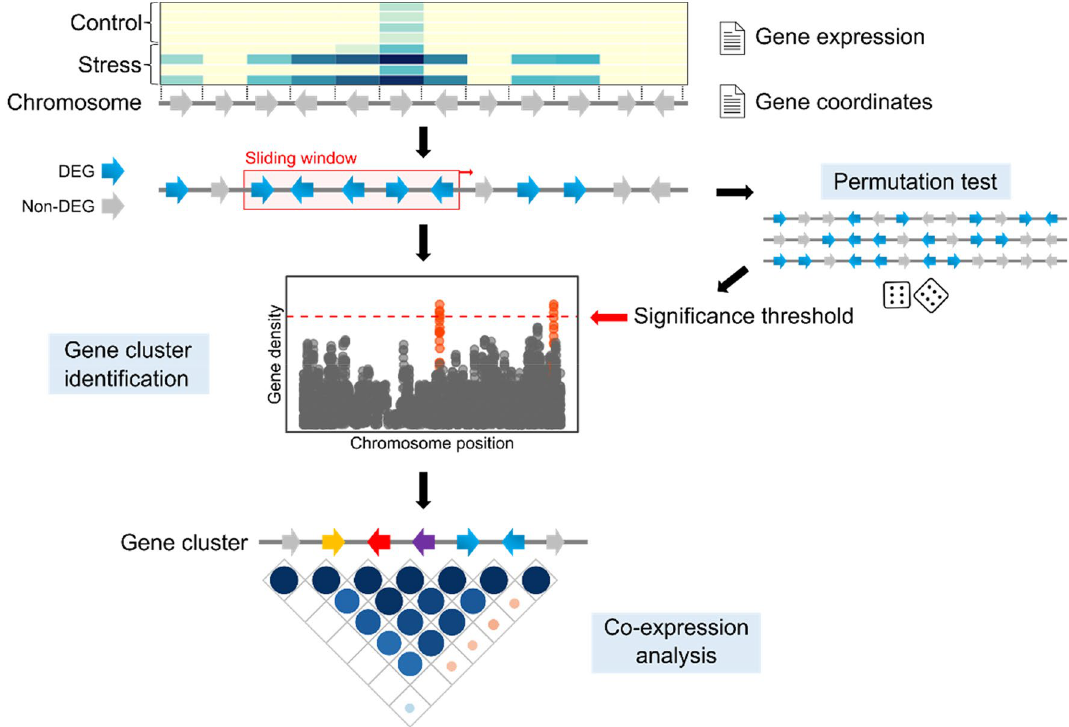
Figure 1. Genome mining of stress-responsive gene clusters. Differential expression analysis was used to identify stress-responsive genes from transcriptomics data. Using chromosomal coordinates of genes from a reference genome, the average number of differentially expressed genes (DEGs) within a sliding window of a user-defined size (hereby called gene density), and the length of a string of consecutive DEGs was calculated. Shuffled data sets were also analysed to determine what values of gene density and consecutiveness can be considered non-random. Clusters of genes that breach this threshold were designated as significantly non- random gene clusters, and their expression profiles are used for co-expression